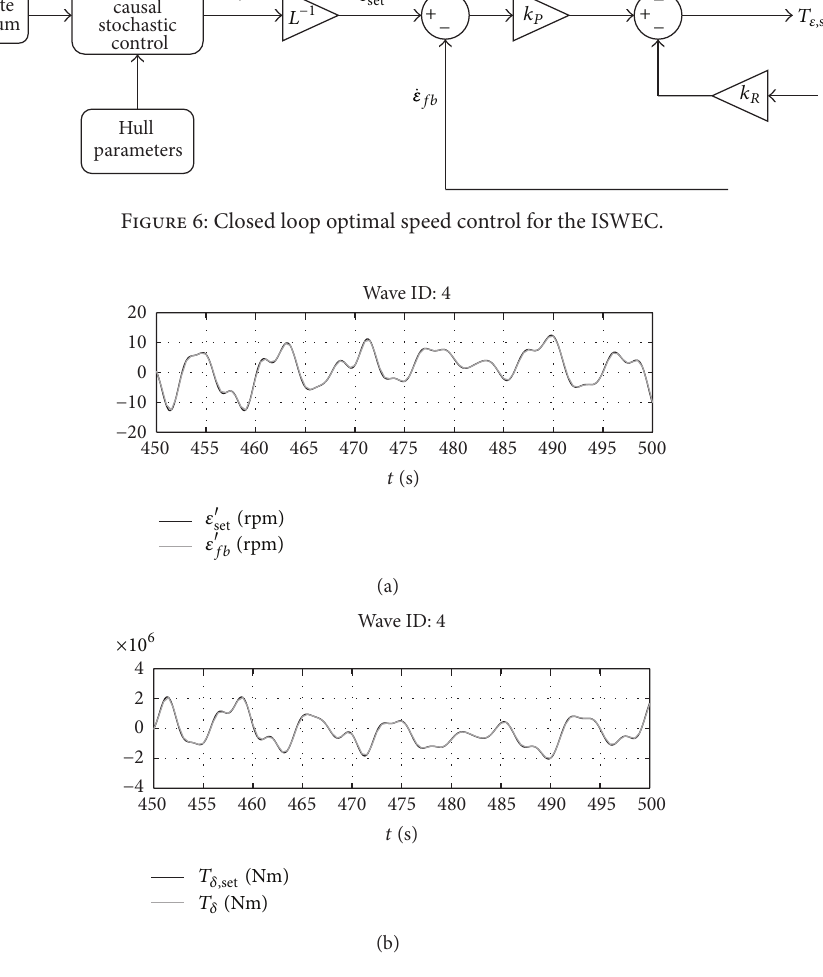
Figure 7: Set versus feedback for gyroscope speed and pitching